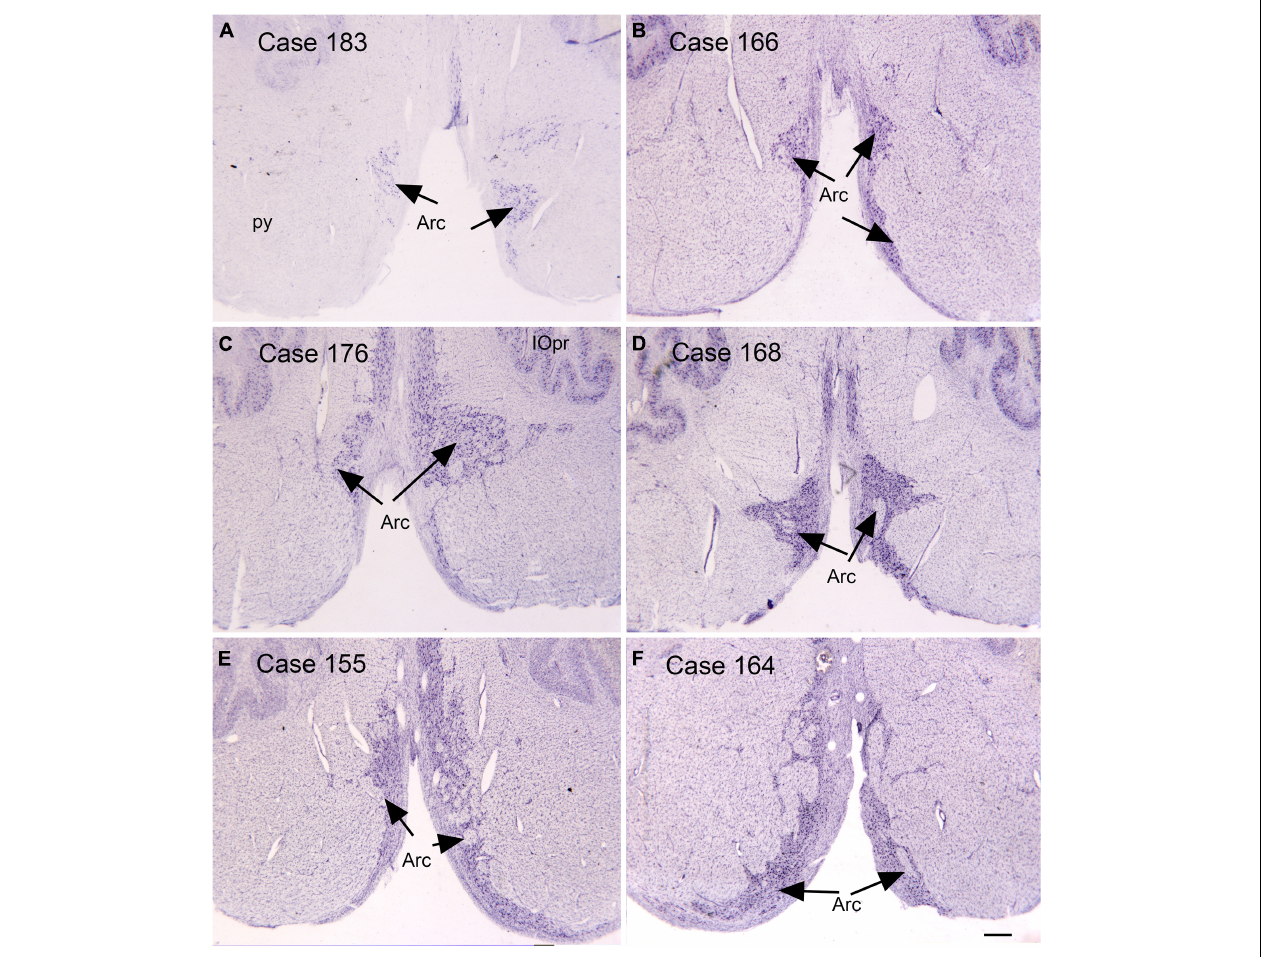
FIGURE 3 | Variability in the arcuate nucleus. (A–F) The arcuate nucleus (Arc, arrows) on cresyl violet stained transverse sections of the human brainstem. Note the differences in size and shape among cases, and the left-right asymmetry within cases. Scale bar = 0.5 mm. Arc, arcuate nucleus; IOpr, principal nucleus of the inferior olive; py, pyramidal